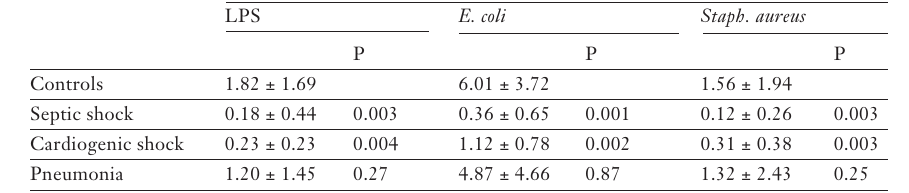
Table 1 ΤΝ F α production by whole blood of normal volunteers (controls), patients with septic shock, with cardiogenic shock or with severe bacterial pneumonia after stimulation with LPS, E. coli and Staph. aureus.